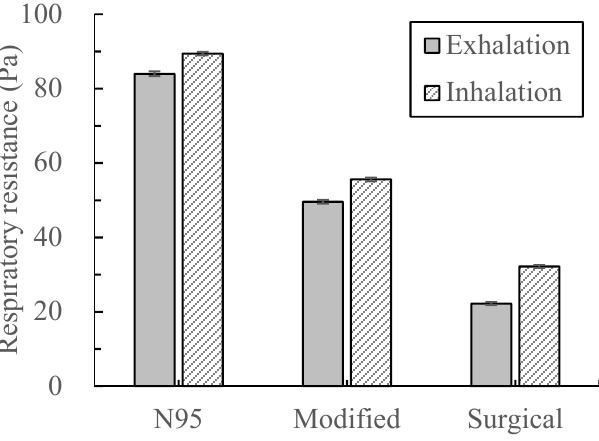
Figure 10. Steady exhalation and inhalation flow resistances of three face masks.